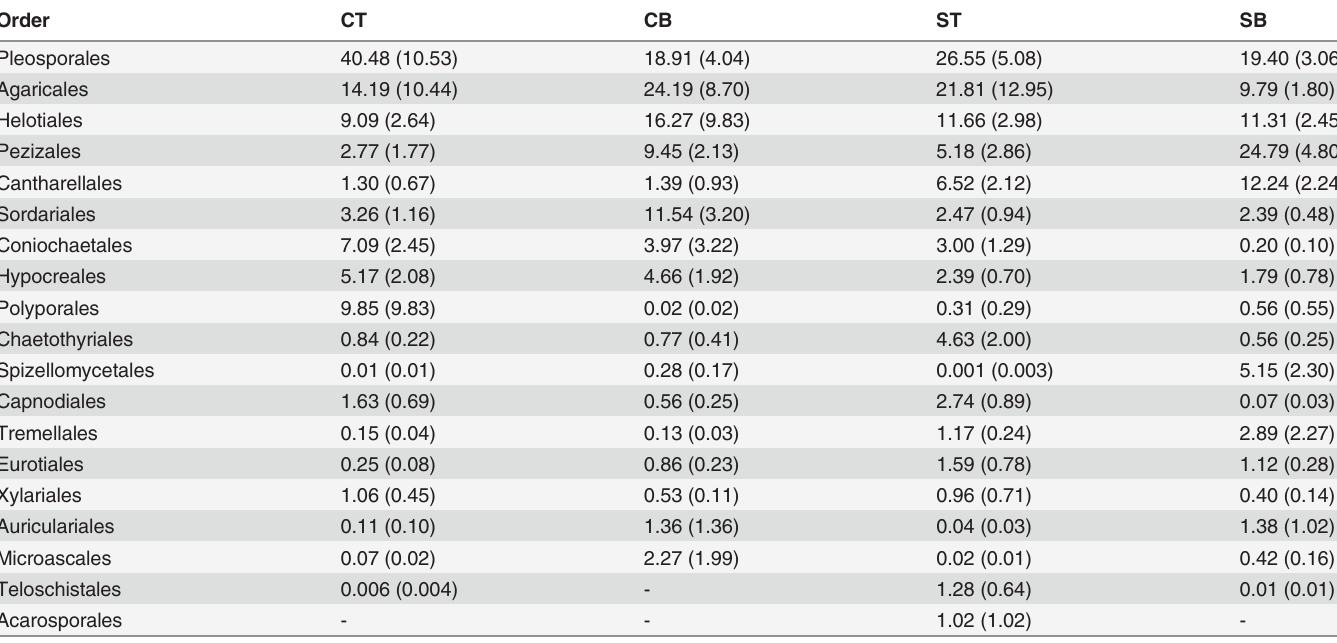
Table 4. Average percentage of the 19 most abundant fungal orders detected in each of the four soil intervals (n = 6 ( ± 1 standard error)).